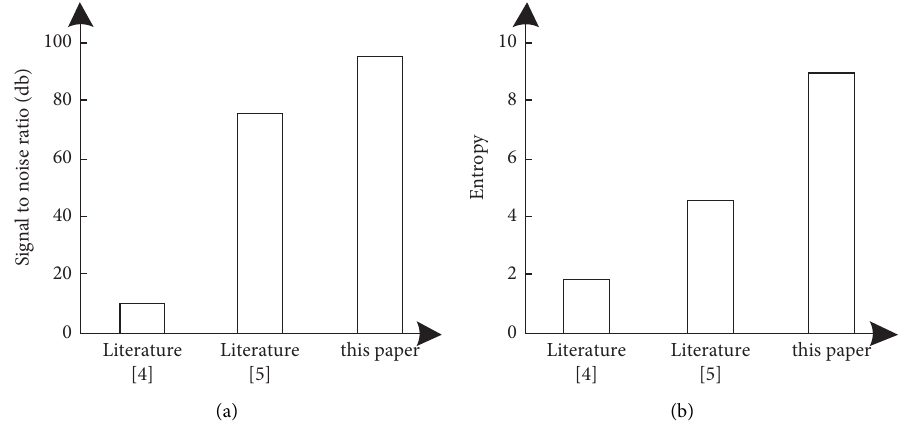
Figure 5: The schematic diagram of evaluation indexes of each algorithm. (a) Peak signal-to-noise ratio. (b) Entropy. Table 2: Comparison results of image enhancement time of three algorithms (s). Number of experiments/times Paper